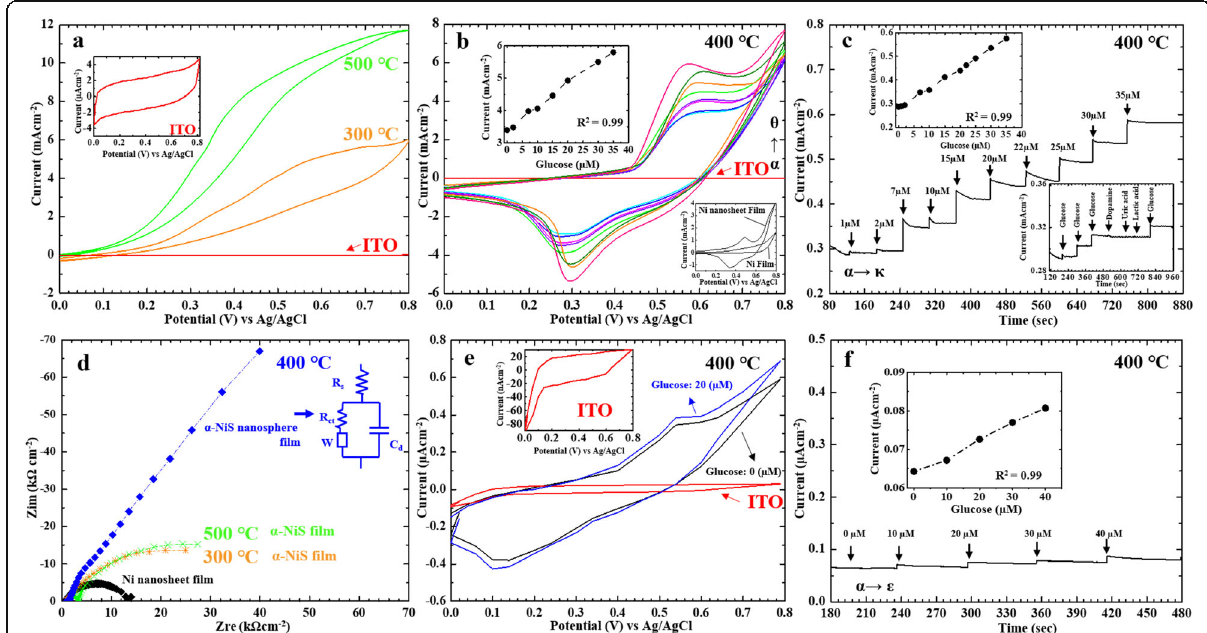
Fig. 3 a Three CVs in the image: the red curve showed the CV of bare ITO; the orange and green curves were the CVs of α -NiS films at different annealing temperatures (300 and 500 °C). Inset: CV of bare ITO/glass. b CV of nano-NiS/ITO in 0.1 M NaOH with different concentrations of glucose: ( α ) 0 μ M, ( β ) 2 μ M, ( γ ) 7 μ M, ( δ ) 10 μ M, ( ε ) 15 μ M, ( ζ ) 20 μ M, ( η ) 30 μ M, and ( θ ) 35 μ M. Inset: top left — plot of oxidation peak current against glucose concentration; bottom — CVs of Ni film and Ni nanosheet film. c The α -NiS nanosphere film was assessed by amperometry in 0.1 M NaOH with different concentrations responses against glucose concentrations; bottom — chronoamperometric response of NiS/ITO in 0.1 M NaOH with 2 μ M glucose and in the presence